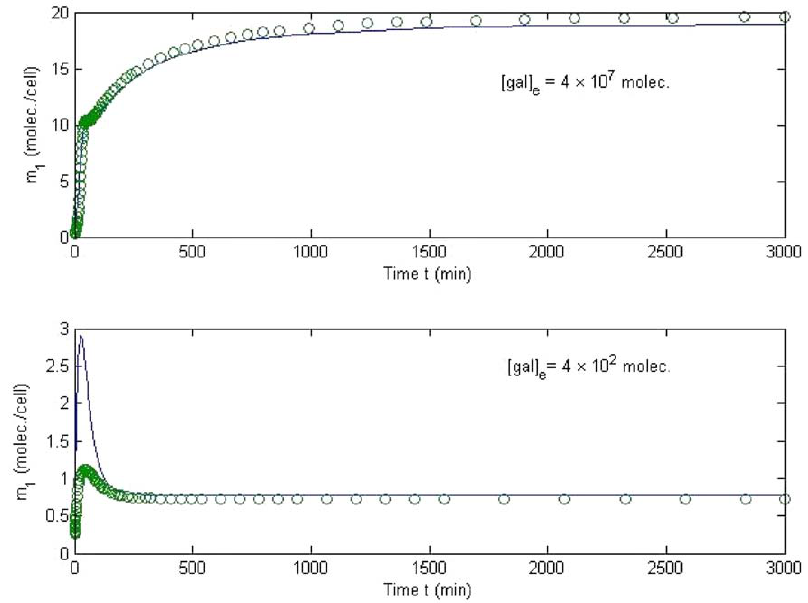
~ 4 | 10 7 molec : and ½ gal (cid:3) ~ 4 | 10 2 molec : are applied e e